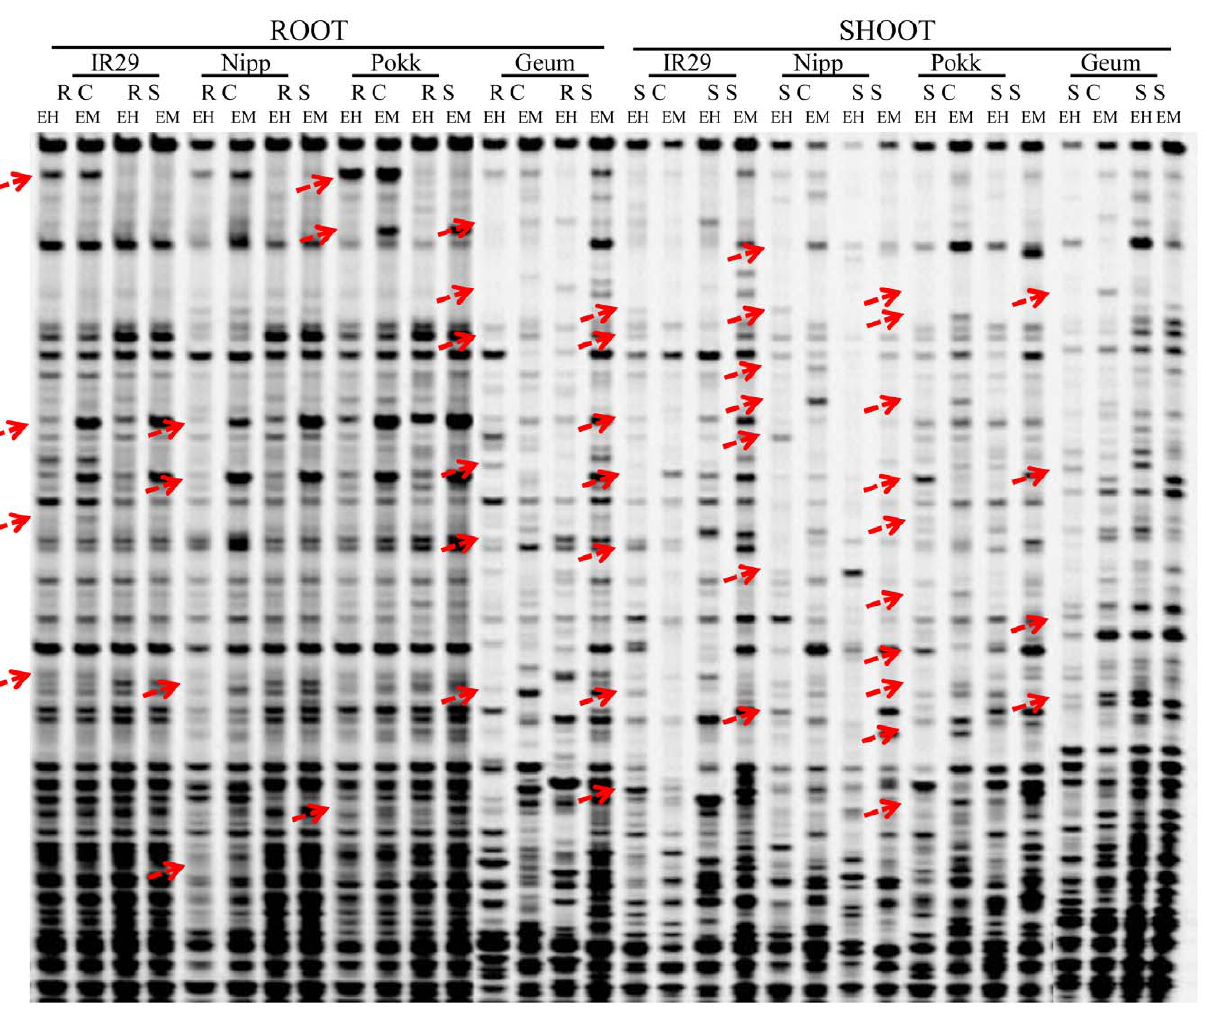
Figure 1. A representative MSAP gel using the primer combination Eco RI-ACG/ Msp I-AATC. Both control and salinity stressed root and shoot of rice genotypes, IR29, Nipponbare (Nipp), Pokkali (Pokk), Geumgangbyeo (Geum) were used for MSAP analysis. EH and EM refer to digestion with Eco RI + Hpa II and Eco RI + Msp I, respectively. RC: root control; RS: root stress; SC: shoot control; SS: shoot stress.